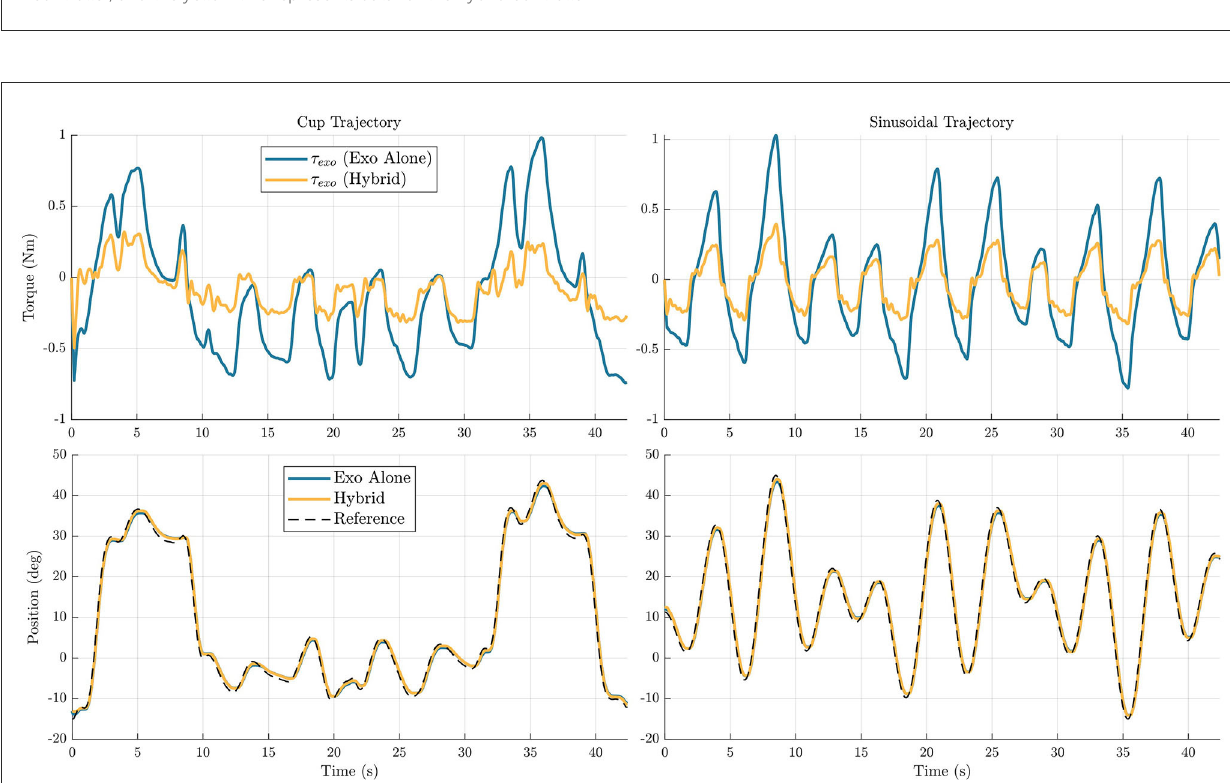
FIGURE9 Wrist flexion/extension joint exoskeleton torque profile from a single subject (top) , and movement profiles averaged across subjects (bottom) are shown for the two different trajectories, cup (left) and sinusoidal (right) . In the plots, the blue line represents data for the exoskeleton alone controller, and the yellow line represents data for the hybrid